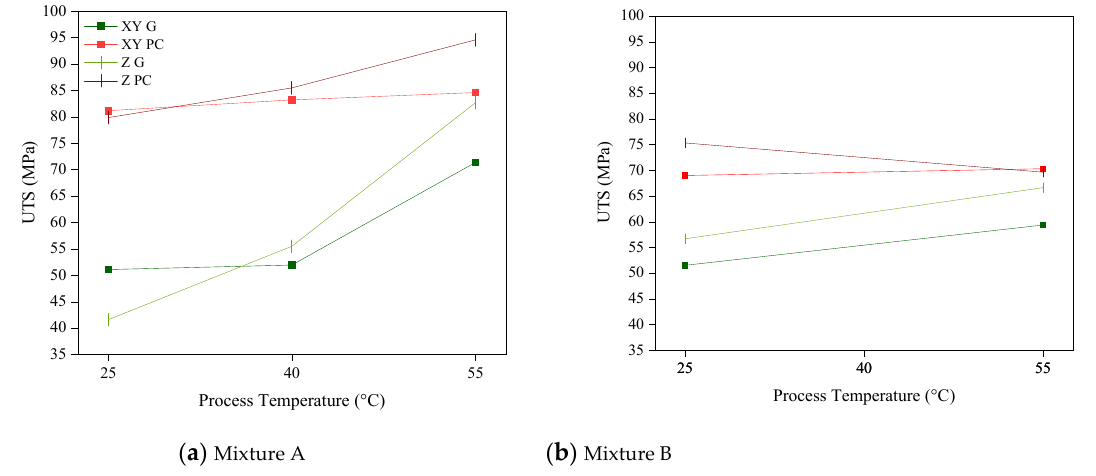
Figure 7. The effect of the process temperature on the UTS of ( a ) Mixture A and ( b ) Mixture B in the XY and Z directions, and the green (G) and post-cured (PC) states.